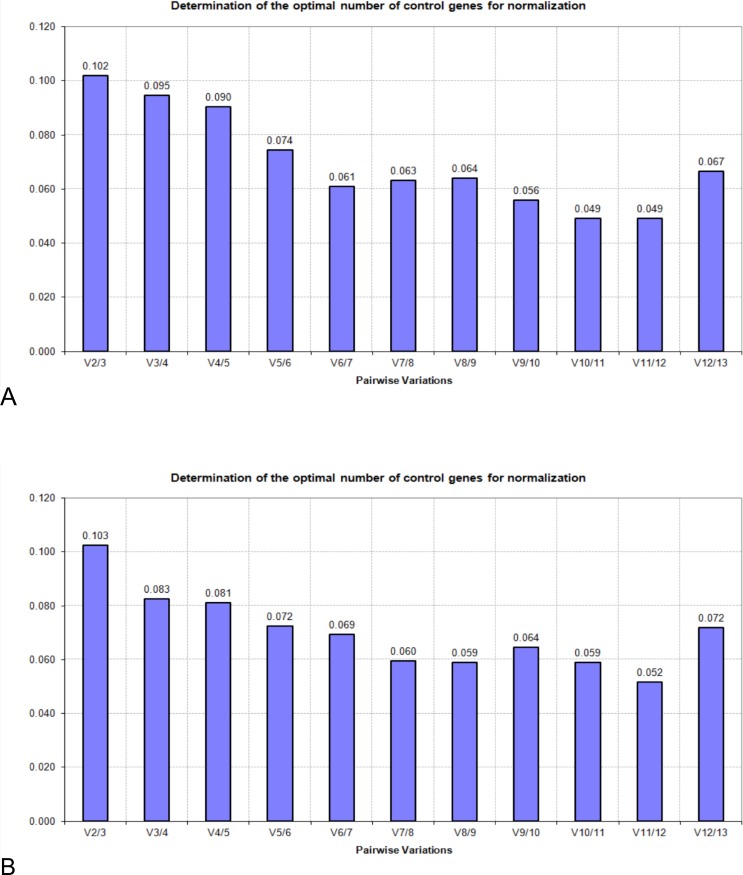
Pairwise variations generated by geNorm algorithm: (A) 60 samples; (B) 30 samples.